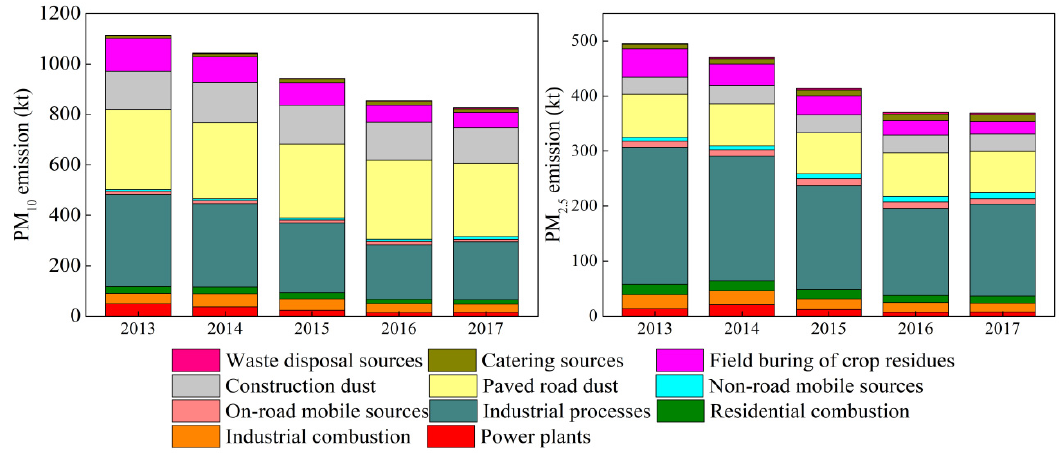
Figure 11. Changes in PM 10 and PM 2.5 emissions in Sichuan during 2013–2017.